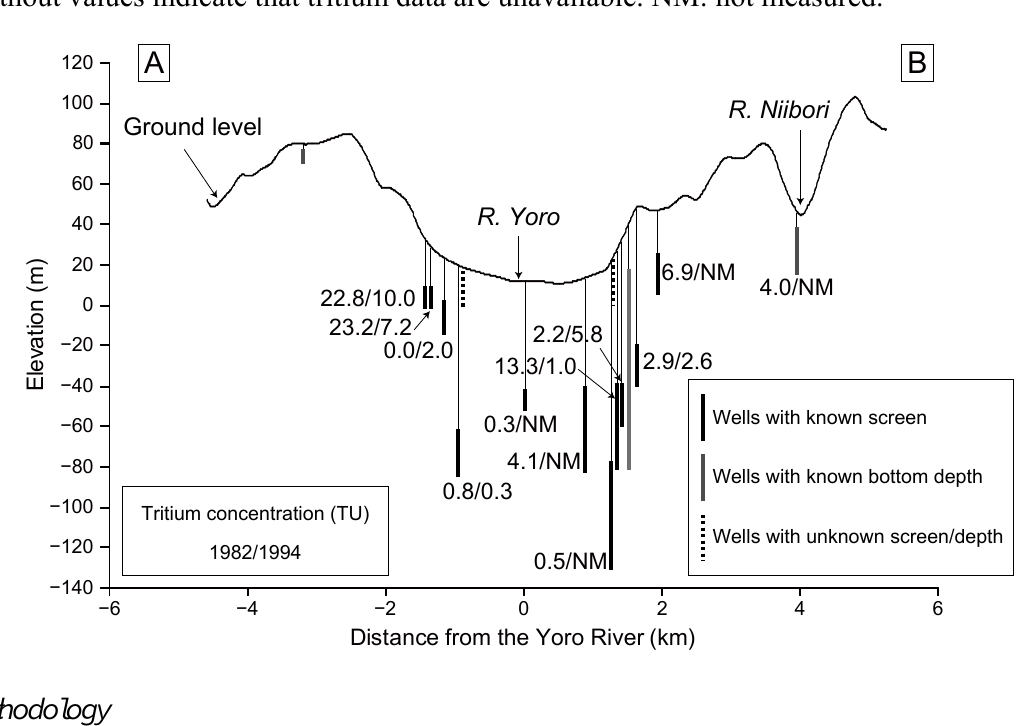
Figure 4. Tritium concentrations measured in 1982 [30] and 1994 [34]. Left and right values for each well are tritium data measured in 1982 and 1994, respectively. Wells without values indicate that tritium data are unavailable. NM: not